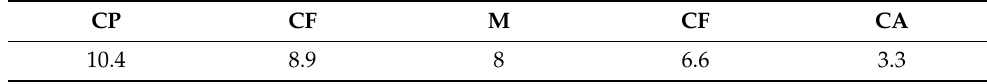
Table 1. Water-analysis values (mg/L) utilized in the experiment.